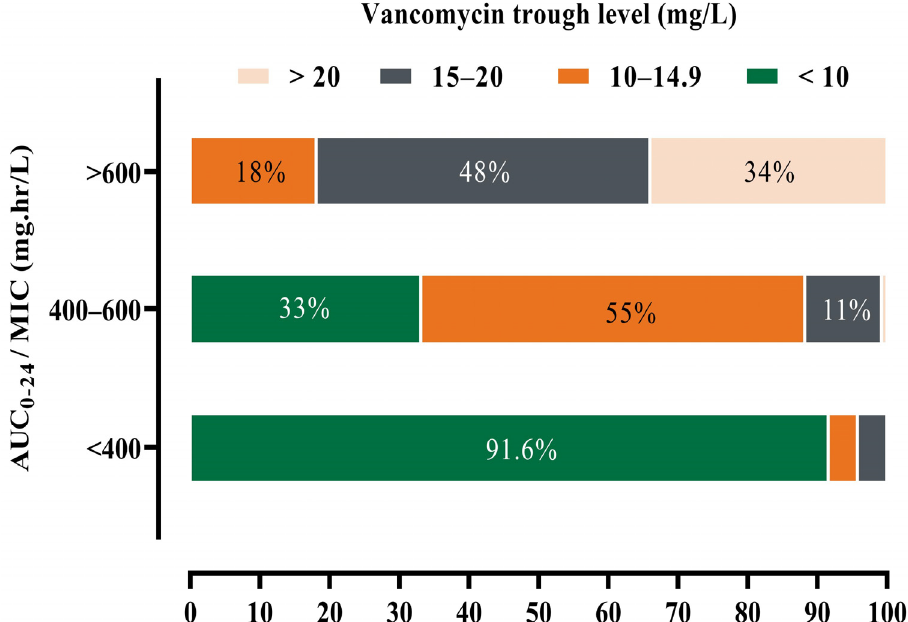
Figure 1. The percentage of patients with vancomycin trough level <10, 10–14.9, 15–20, >20 among each AUC 0–24 level. low AUC 0–24 < 400 mg · h/L n = 71 (20.8%), normal AUC 0–24 400–600 mg · h/L n = 127 (37.1%) and high AUC 0–24 > 600 mg · h/L n = 144 (42.1%); AUC: the area under the curve.